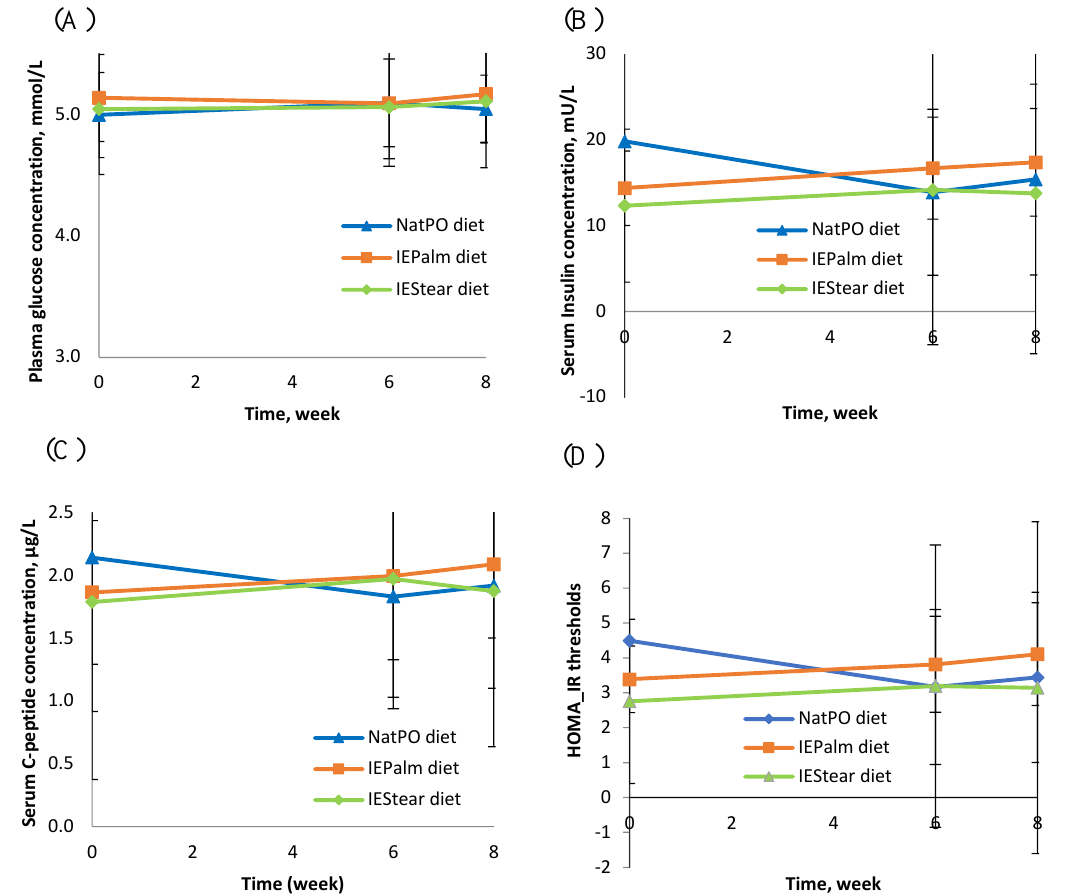
Figure 3. Concentrations of fasting plasma glucose ( A ), serum insulin ( B ), serum c-peptide ( C ), and HOMA-IR threshold after eight weeks feeding intervention among three diet group (NatPO diet, n = 28; IEPalm diet, n = 29; IEStear-diet, n = 28). The values represent means ± SDs at week 0, week 6, and week 8. HOMA-IR, Homeostasis Model Assessment.